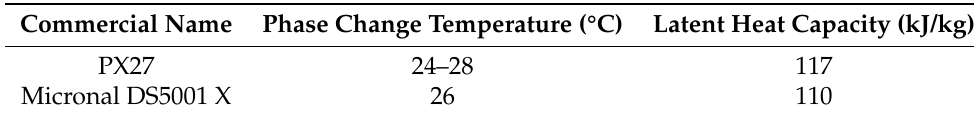
Table 2. PCM thermal properties.